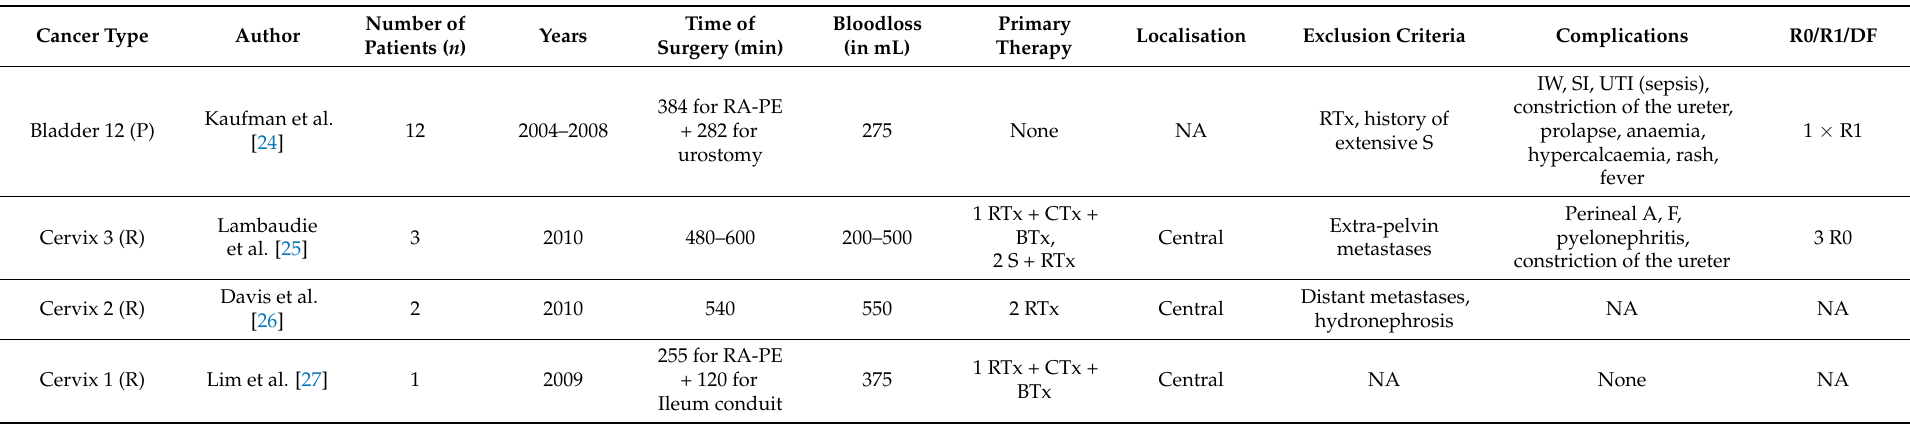
Table 2. Study details of robotically assisted